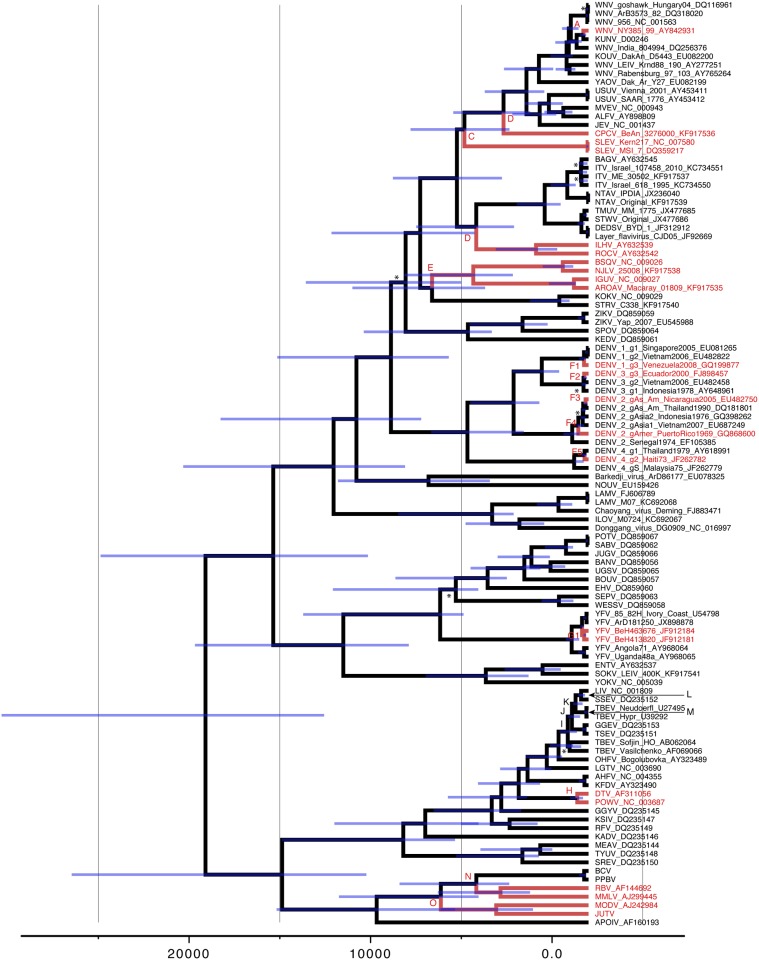
Maximum clade credibility tree summarized from the Bayesian molecular clock analysis.All nodes attained maximal probability support except for those indicated by a * (posterior probability < 0.95). The node age uncertainty is indicated using 95% highest posterior density (HPD) interval bars in blue. Old World and New World ancestral states are indicated by black and red branches/nodes respectively. Nodes of interest are listed A to N as referred in the text.